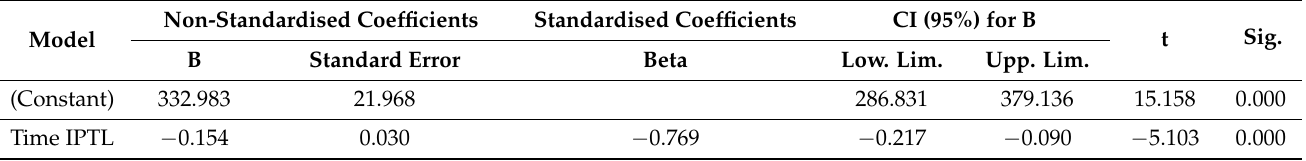
Table 8. Coefficients of the model a